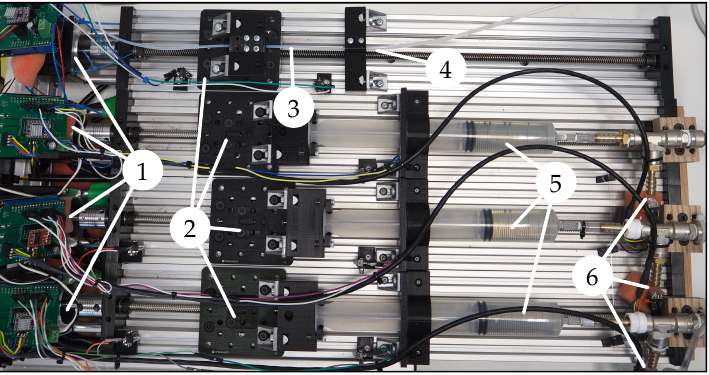
Figure 3. Three syringe pumps and prismatic joint setup. (1) Stepper motors and electronics. (2) Linear stages. (3) Flexible rod. (4) Bowden tube. (5) Syringes filled with water. (6) Pressure